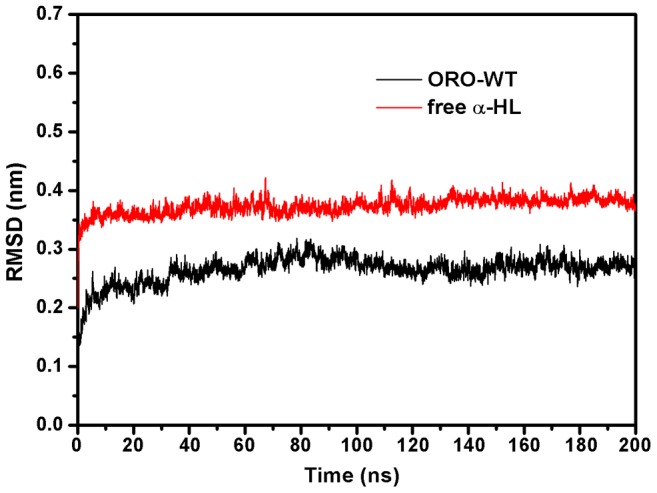
RMSD of Cα atoms of “Loop” from their initial coordinates as a function of time.MD simulations of the α-HL-ORO complex displayed significantly decreased dynamics in the “Loop”. The two systems were found to reach equilibrium after 10 nanoseconds and displayed the following RMSD trends: RMSDfree>RMSDwt.